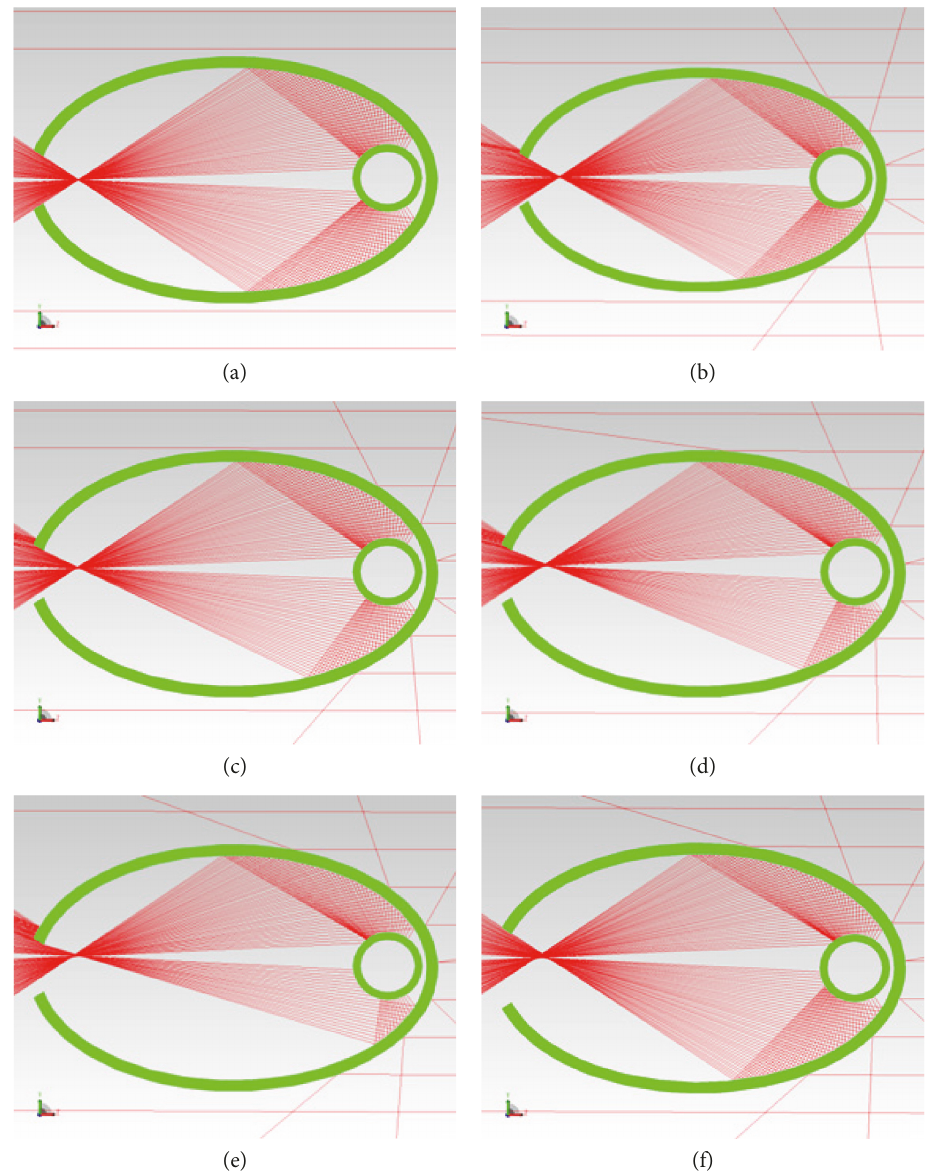
Figure 3: Light distribution in the elliptical cavity when (a) under ideal condition; (b) L (d) L =12mm and α =0.15 ° ; (e) L el